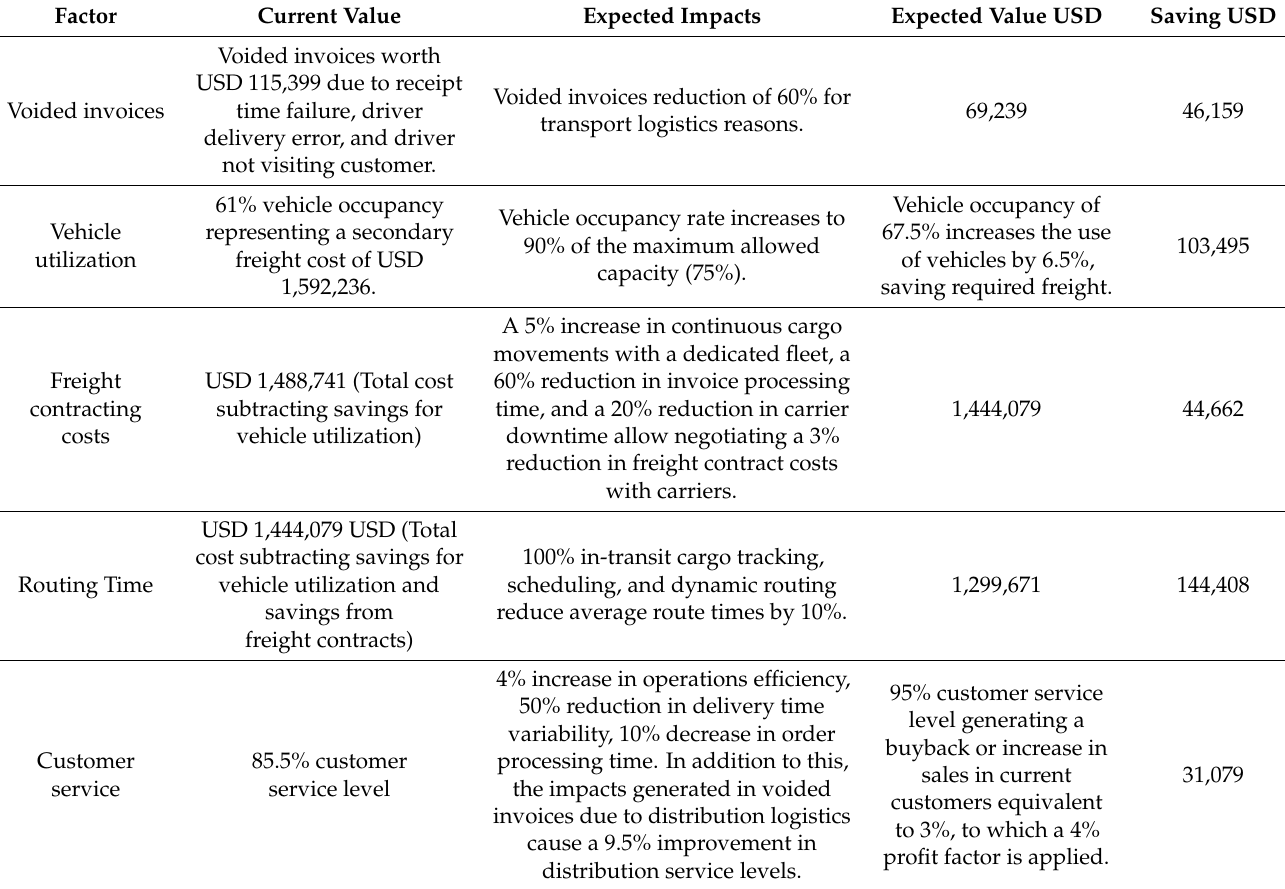
Table 15. Productivity impacts generated by the implementation of the